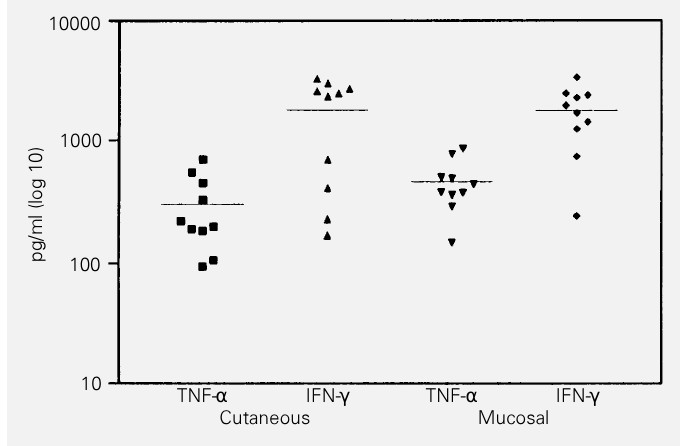
Figure 1 - TNF- a and IFN- g levels in Leishmania antigen-stimulated PBMC from patients with cutaneous and mucosal leishmaniasis.